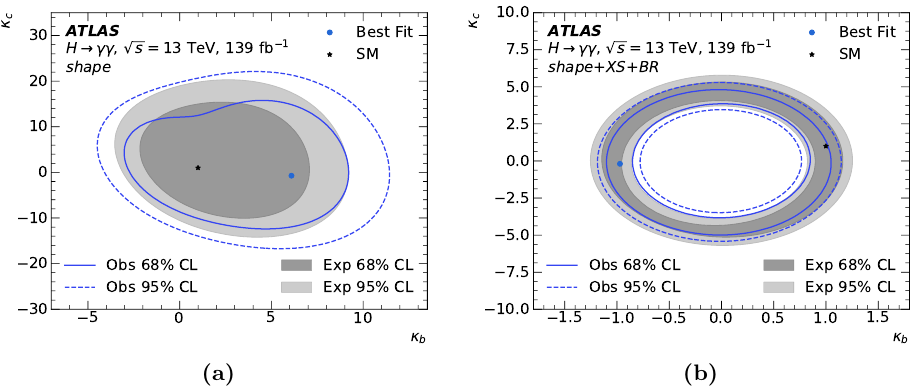
Figure 18. Observed and expected 2D limits on κ b and κ c when considering modifications of (a) the shape and (b) the shape and normalisation (with ‘XS+BR’ denoting ‘cross-section and branching ratio’) at 68% and 95%